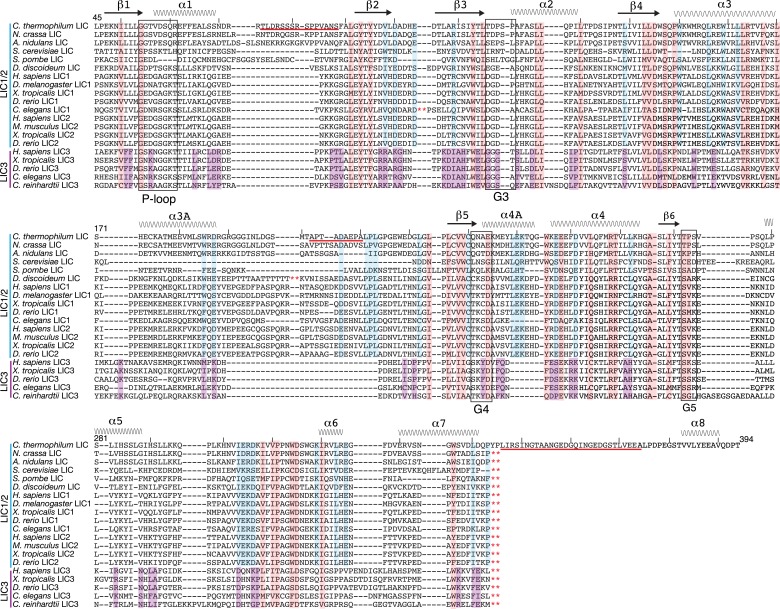
Conservation of LIC sequences and alignment with the LIC structure.20 LICs were aligned via Promals (Pei and Grishin, 2007) (the C. thermophilum LIC pdb aided the alignment), and only the conserved sequence of the G domain is shown with the numbering based on C. thermophilum LIC. The P-loop, G3, G4, and G5 motifs were identified by the LIC structure and are labeled. The secondary structure of the C. thermophilum LIC is depicted above the sequences, and the residues missing in the structure are underlined in red. The red asterisks denote where sequence was taken out for space. Residues that were 80% conserved among only LIC1 and 2 sequences (12 out of 15), only LIC3s (4 out of 5), or universally conserved among all LICs (16 out of 20) are highlighted light blue, purple, and pink, respectively. Only the C. thermophilum LIC sequence extends to 394; all the other sequences were truncated with respect to C. thermophilum LIC, a.a. 343, because their predicted α-helix 8 extends beyond the alignment shown here.